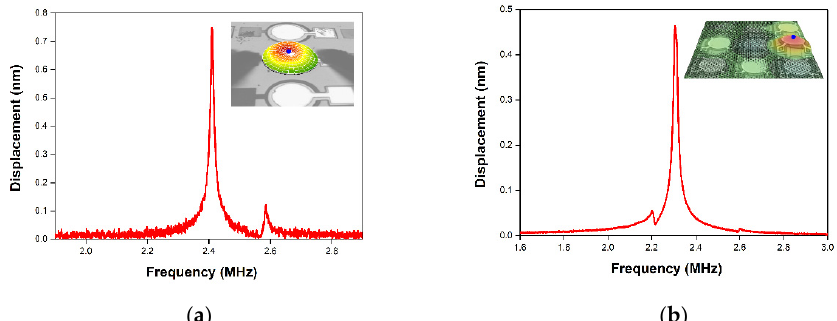
Figure 9. Mechanical displacement of the fabricated AlN pMUT device. ( a ) Single and ( b ) array pMUT with periodic chirp input.